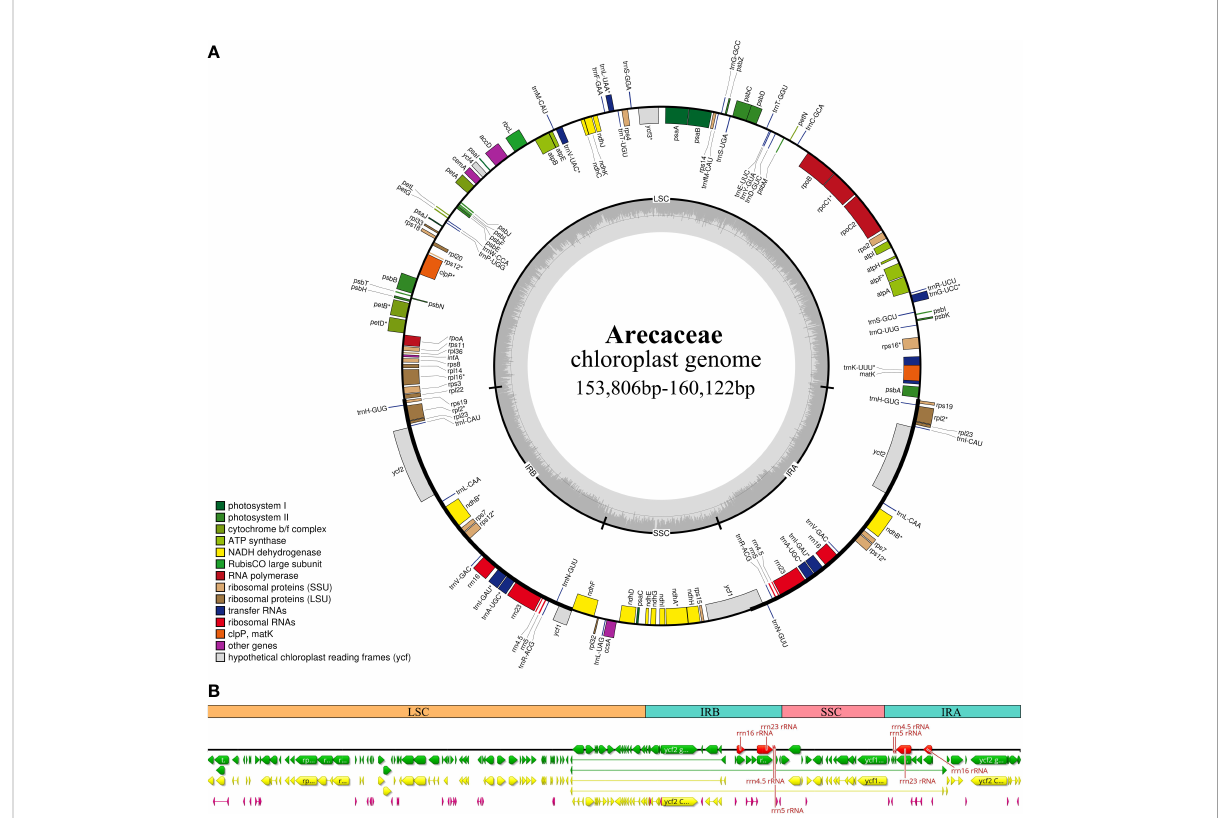
FIGURE 2 Chloroplast genome map of Arecaceae. (A) Circular form. Genes inside the outer circles are transcribed clockwise and those outside the circles are transcribed counterclockwise. The gray variation area in the inner circle indicates the GC content of the chloroplast genome. Different colors indicate different functional genes. (B) Linear form. Different colors indicate different functional genes, green indicates Genes, yellow indicates Protein Coding Genes, red indicates rRNA genes, and purple indicates tRNA